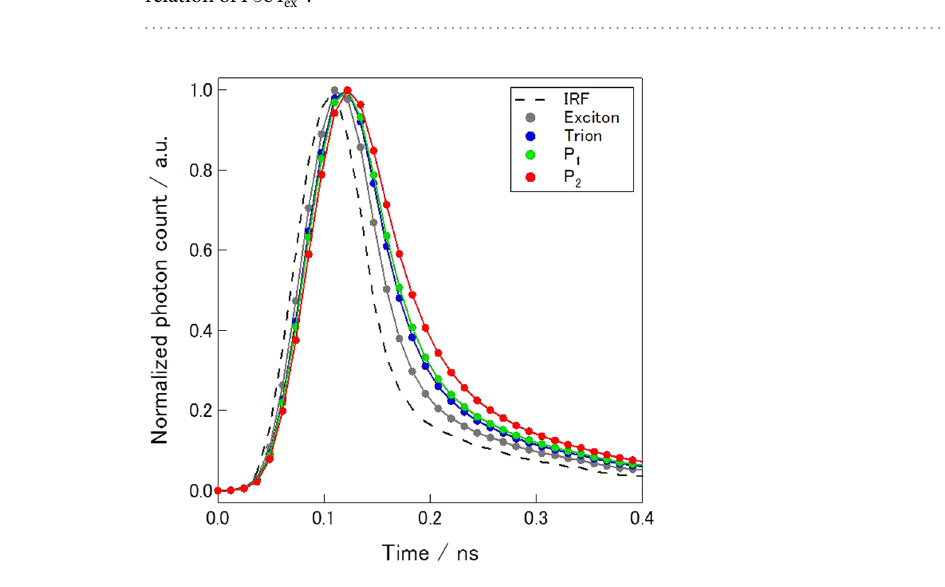
Figure 3. ( a ) PL spectra of WS 2 / h BN measured with excitation power ranging from 0.37 to 6.6 μ J/cm 2 at 80 K. ( b,c ) Plots of PL intensities of trion, P 1 and P 2 verses that of exciton. Green, blue and red filled squares correspond to PL intensities of P